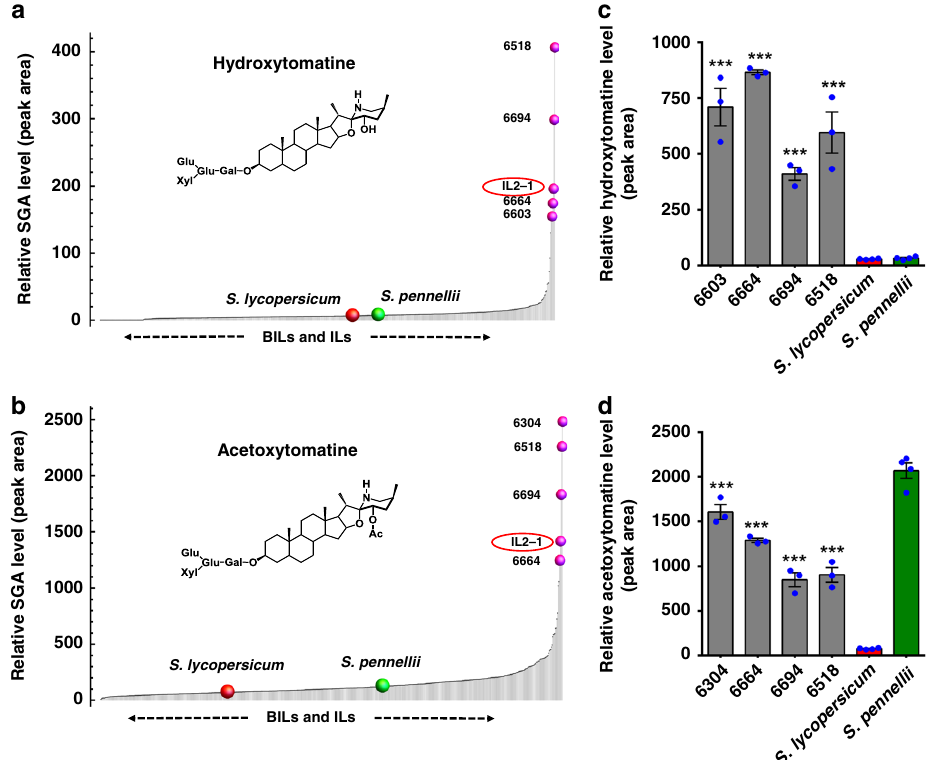
Fig. 2 LC-MS-based screening of hydroxytomatine and acetoxytomatine SGAs in the BILs and ILs. a , b Levels of hydroxytomatine ( a ) and acetoxytomatine ( b ) detected following screening of leaf tissues ( n = 1, single replicate obtained using the leaf-dipping method) of BIL and IL population (total 671 lines). SGA levels presented in the plots were arranged in ascending order. Top fi ve BILs/ILs showing the highest SGA content are marked by a pink spot. Refer to Supplementary Data 1 for details regarding SGA level across the BIL and IL population. c , d Validation of hydroxytomatine ( c ) and acetoxytomatine ( d ) content in extracts of ground leaf tissue from selected topmost BILs (from a , b ) along with S. lycopersicum ( cv . M82) and wild species ( S. pennellii ) parents. Values indicate means ± standard error mean ( n = 4 for parental lines and n = 3 for selected BILs and IL2-1 line). Asterisks indicate signi fi cant changes compared to S. lycopersicum samples as calculated by Student ’ s t test (* P value < 0.05; ** P value < 0.01; *** P value < 0.001). LC-MS was used for targeted SGA pro fi ling. The source data of Figs. 2c and 2d are provided as a Source Data fi